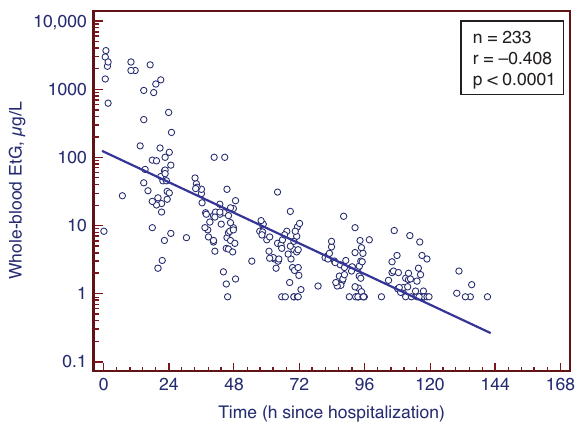
Figure 4: The correlation between EtG in serum and urine presented in logarithmic scale. Data are combined from day 1 of study 1 and positive cases from study 2. The urine concentrations were normalized using the creatinine concentrations, which increased the correlation coefficient from 0.790 to 0.907. The statistical calculations were with non-logarithmic